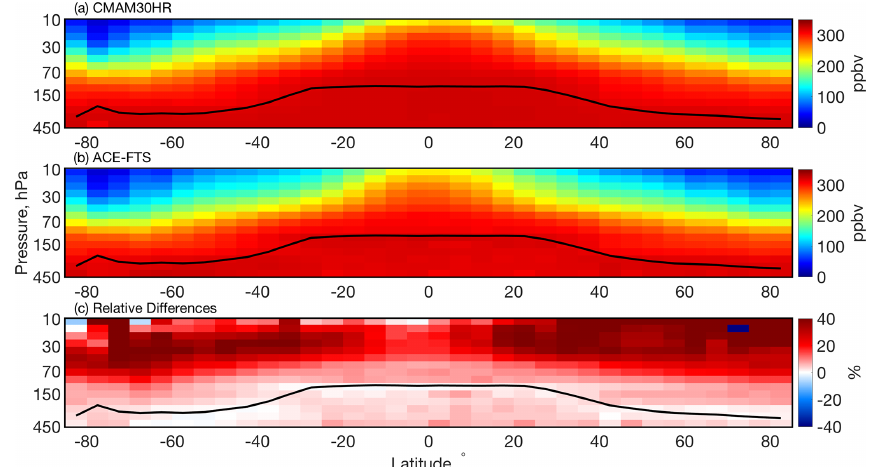
Figure 6. Zonally averaged annual-mean latitude-altitude distributions of N 2 O: (a) CMAM30HR (ppbv), (b) ACE-FTS (ppbv), and (c) the mean relative difference (in %) between sampled model and ACE-FTS profiles, divided by the ACE-FTS profiles (100 × (CMAM30HR − ACE-FTS) / ACE-FTS). The black line indicates the location of the thermally defined tropopause.